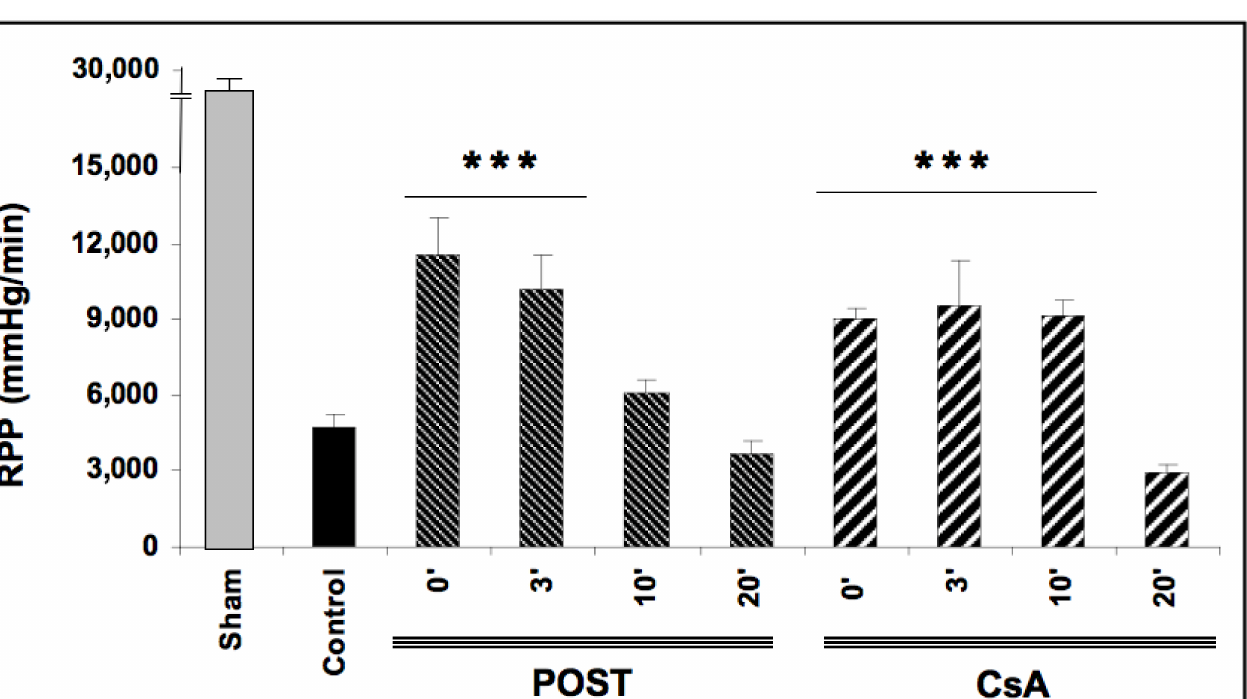
Figure 1. Functional recovery (rate pressure product or RPP) assessed at reperfusion. Postcondition- ing (POST) lost its efficacy if delayed beyond 3 min of reperfusion, whereas cyclosporine A (CsA) administration showed higher RPP even after a 10 min delay. N = 6 hearts/group. *** p < 0.001 vs.